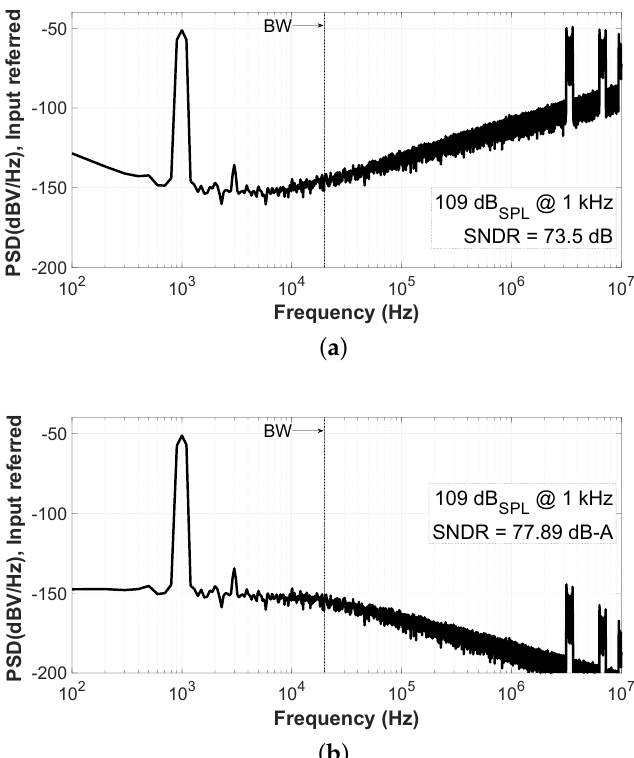
Figure 14. Measured spectrum for an input signal of 109 dB SPL (67.5 mV rms ) at 1 kHz: ( a ) Non-A-Weighted; ( b ) A-Weighted.